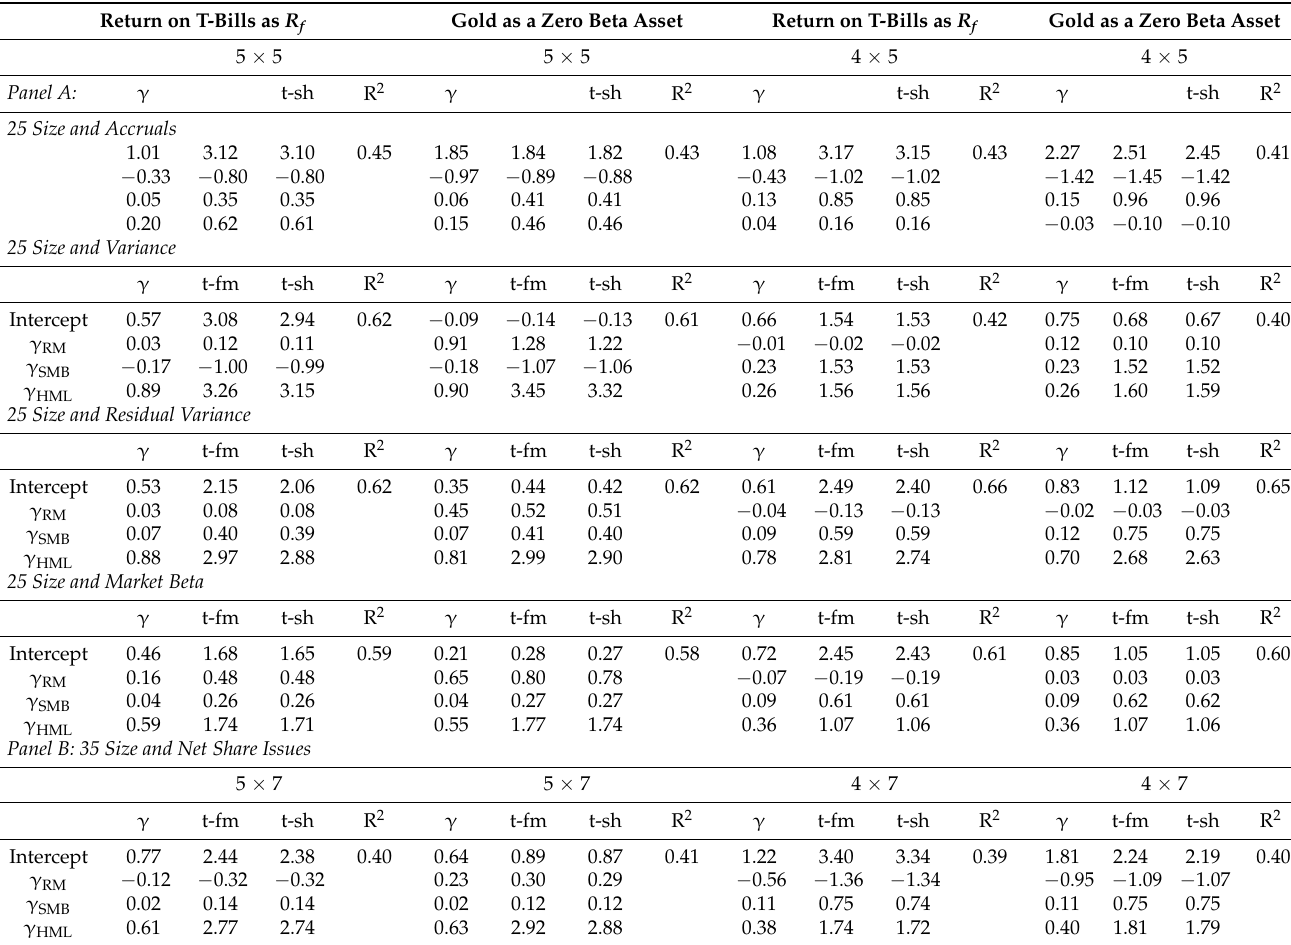
Table 15. Fama–MacBeth tests for three-factor and G-three-factor model from January 1981 to December 2015. Results represent monthly percent returns. Panel A shows results on 25 size and accruals, 25 size and variance, 25 size and residual variance, and 25 size and market beta portfolios, and Panel B shows results on 35 size and net share issues portfolios with (5 × 5) and without microcaps (4 × 5); γ is the average coefficient, t-fm is the t-statistics from Fama–MacBeth procedure, t-sh is the Shanken (1992) errors-in-variables corrected t-statistic, and R 2 is the average cross-sectional R-squared of the tested models.